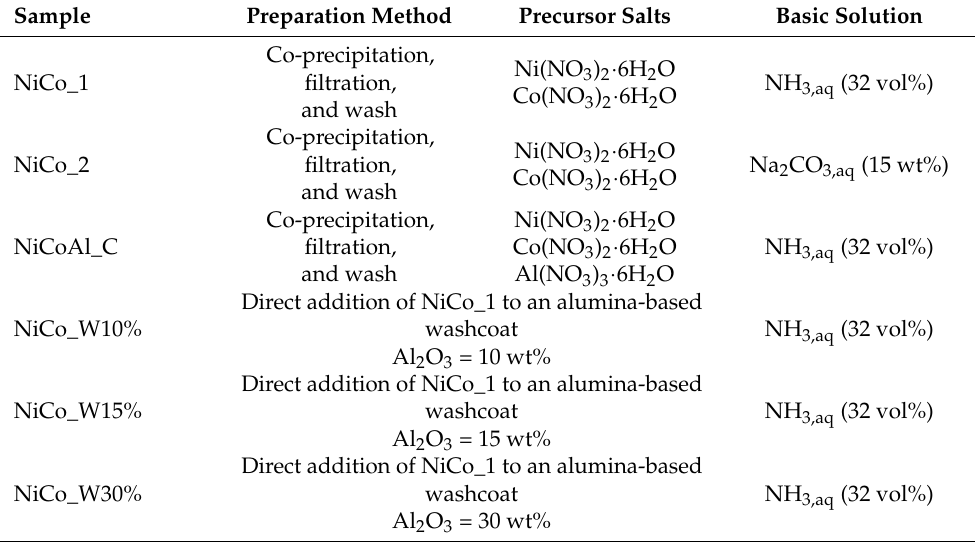
Table 2. Resume of the powder samples preparation